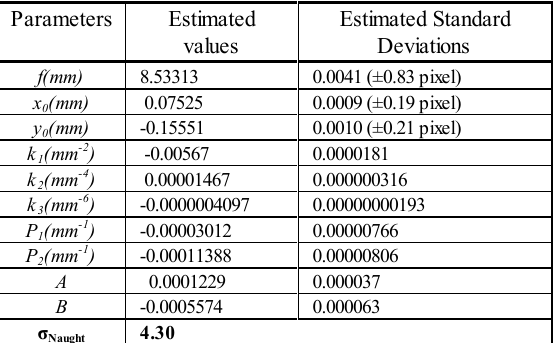
Table 2. Results of the camera calibration process with the Collinearity model.